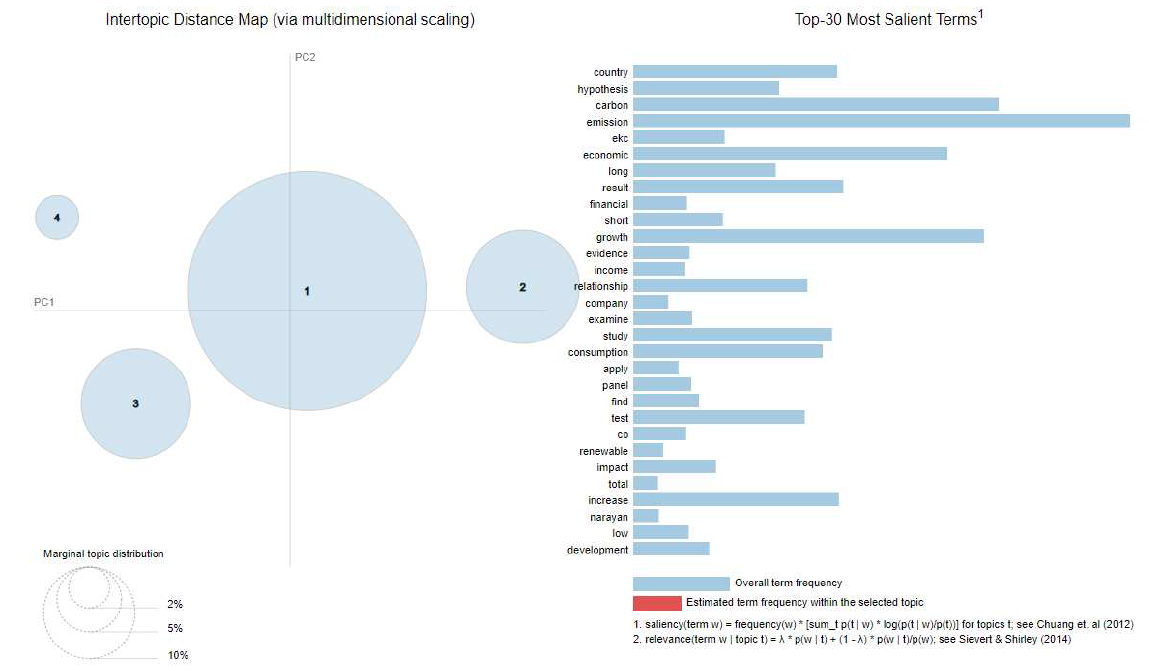
Figure 6. Visualization of inter-related